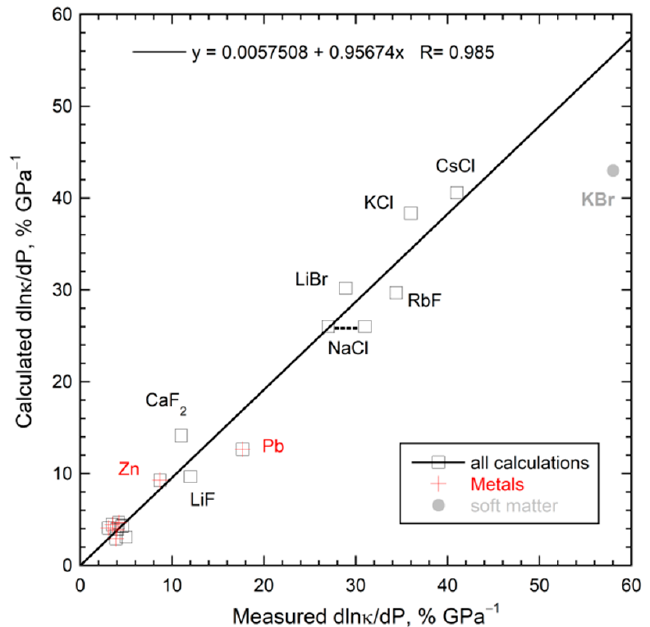
Figure 15. Calculations using (42) compared to measured transport data at pressure from Table 3. KBr exemplifies the soft, hydroscopic alkali halides ( B T < 16 GPa). Reliable data on ∂ B / ∂ T or δ T were not found for Ni, Sn, or Gd.